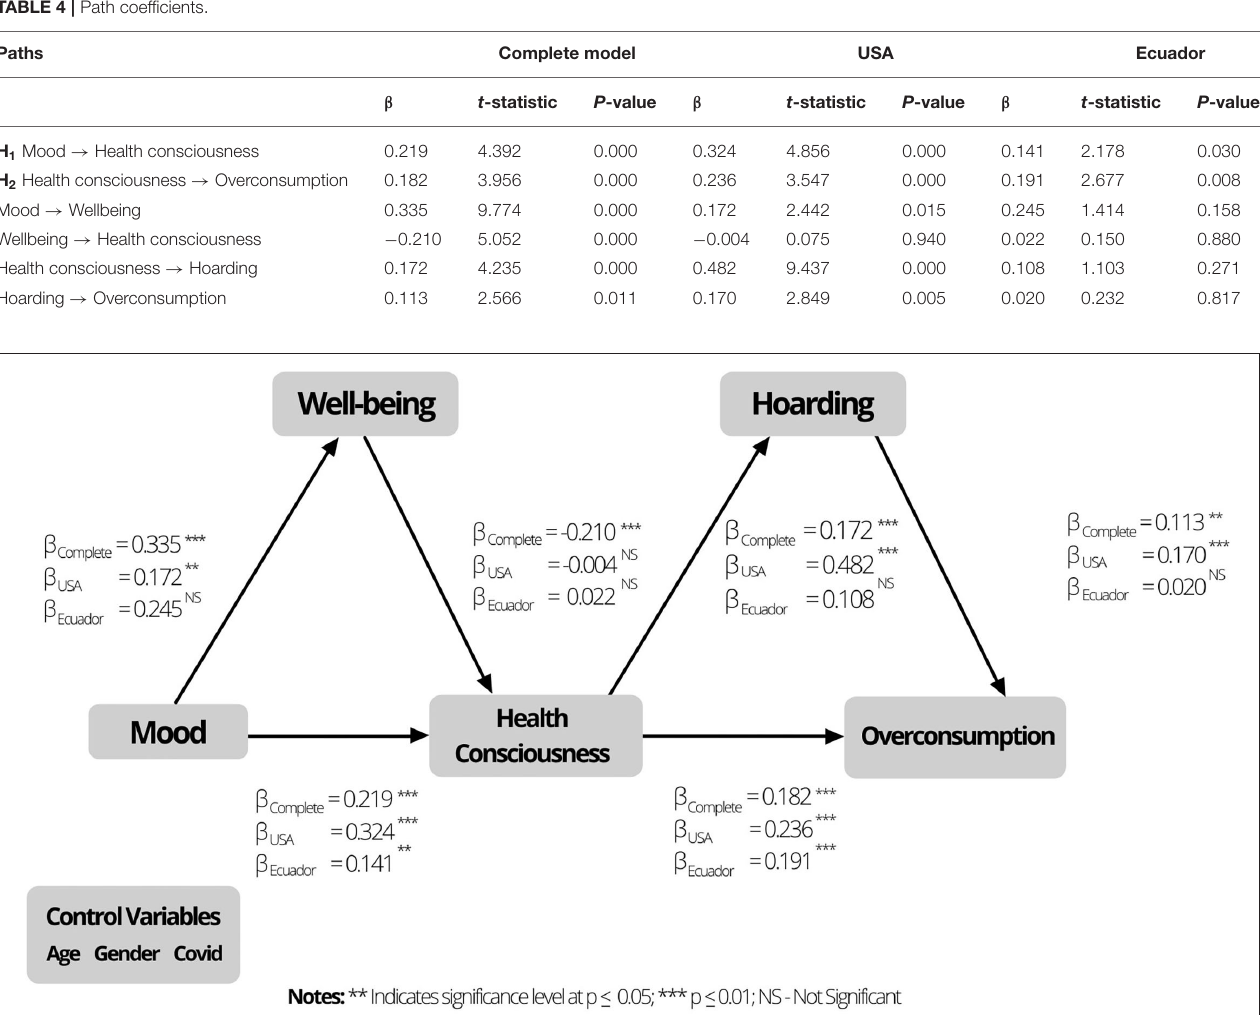
FIGURE 1 | Model’s path